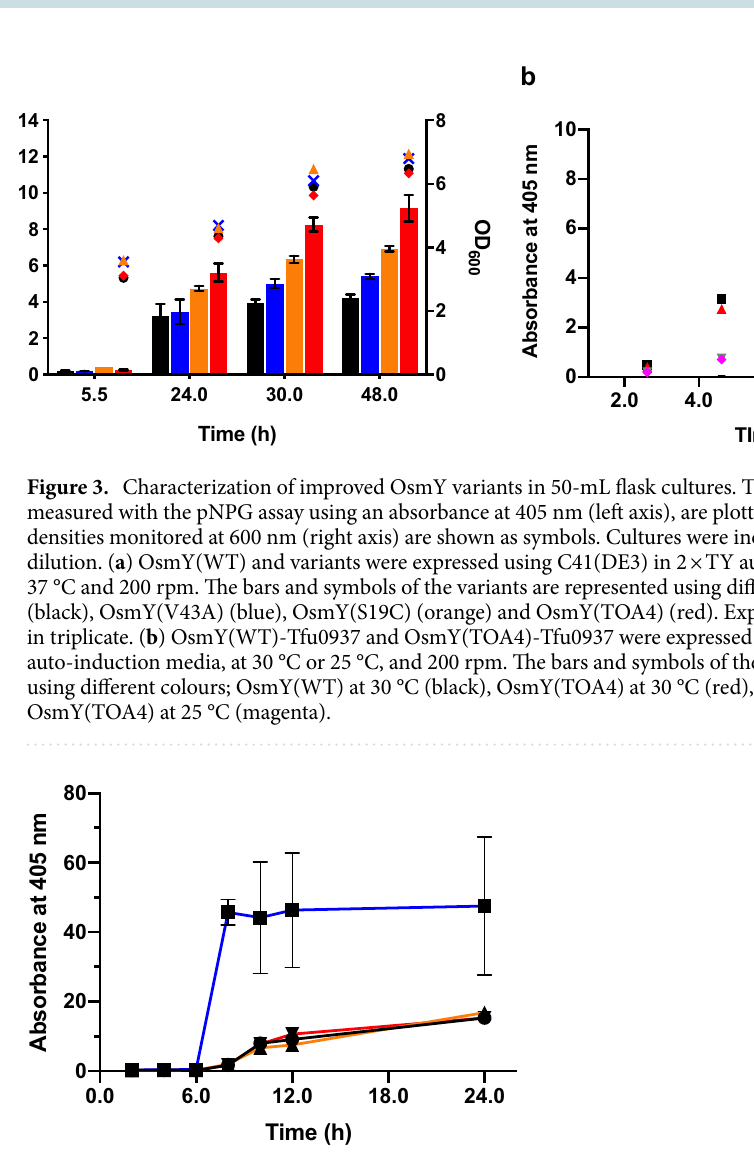
Figure 4. The OsmY-Tfu0937 activity in the spent medium of single site-directed mutants was measured with the pNPG assay using an absorbance at 405 nm. Cells were cultivated in 20-mL of 2 × TY auto-induction media at 37 °C. Culture was inoculated using 1:100 dilution and 0.5 mL culture was sampled at various time points for activity assay. Experiments were performed in triplicate. The samples are represented using different colours; OsmY(WT)—black line, OsmY(L6P)—blue line, OsmY(S154R)—orange line and OsmY(V191E)—red